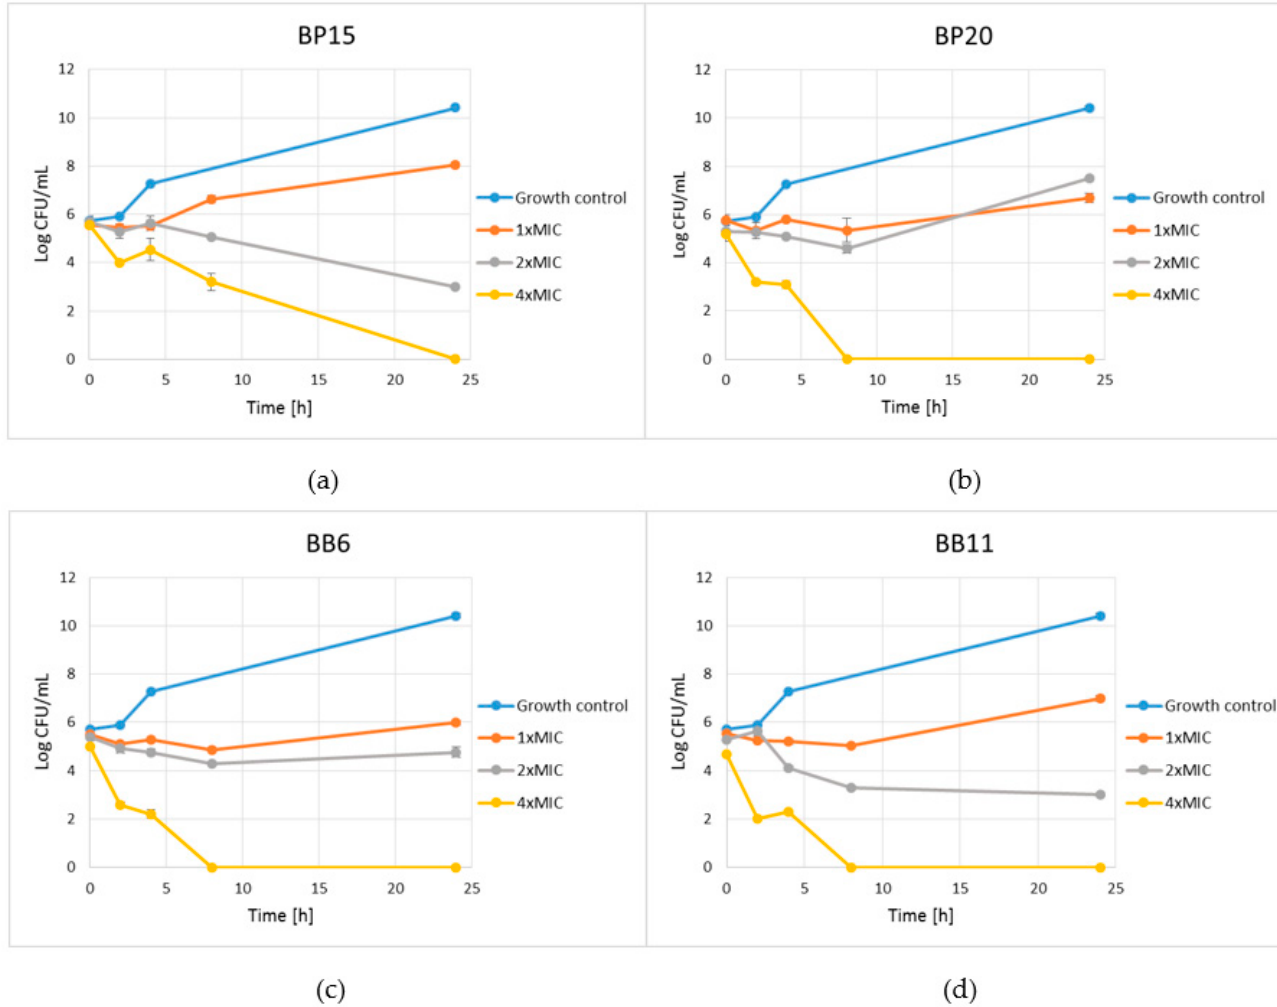
Figure 1. Kill-time assay for selected ethanolic extracts of bee pollen and bee bread tested against S. aureus ATCC 29213 at or above the MIC. The growth control contained no extracts; ( a ) BP15, ( b ) BP20, ( c ) BB6, ( d ) BB11. The results are presented as means ± SDs ( n = 3). Data without error bars indicate that the SDs are too small to be observed on the graph.